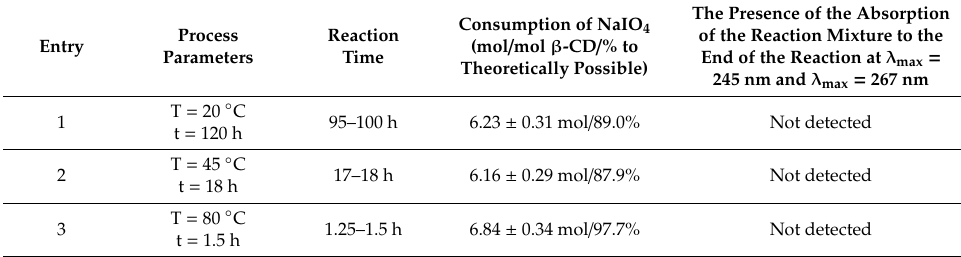
Table 1. Comparative characteristics of the β -CD oxidation process using di ff erent parameters.